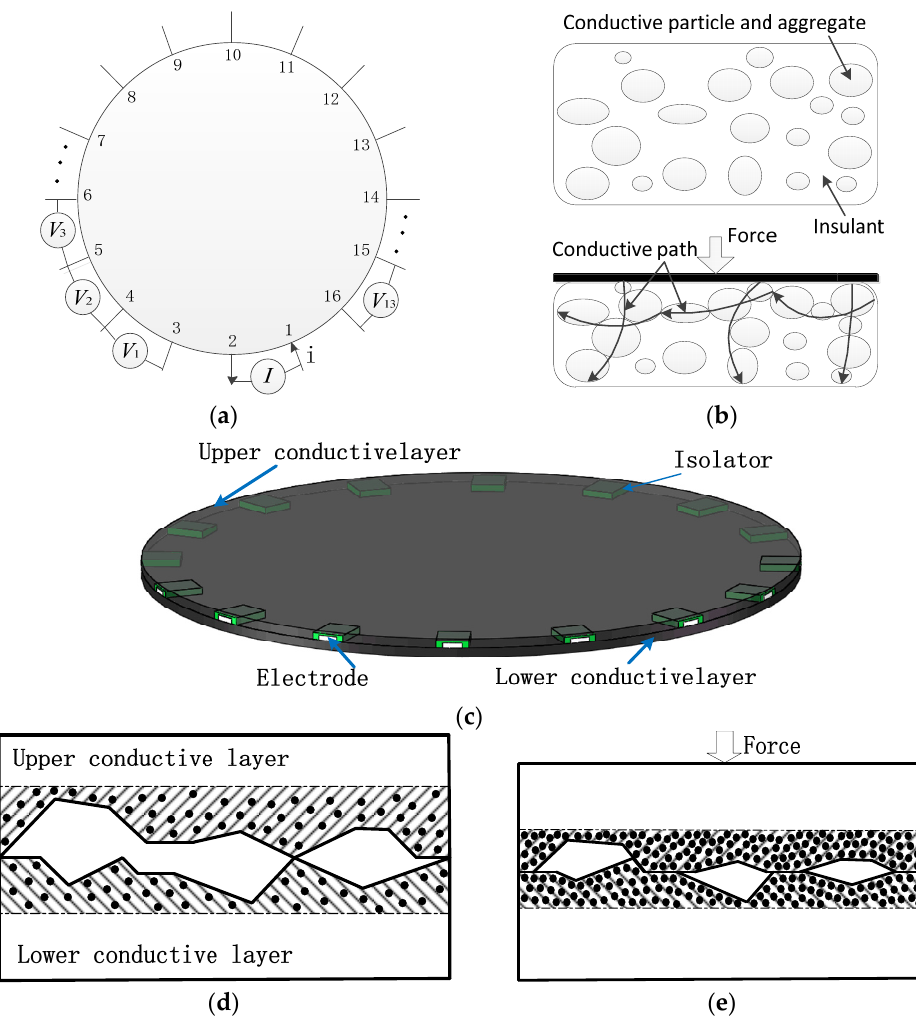
Figure 1. The structure and principle of double-layer piezoresistive sheets tactile sensor: ( a ) The schematic of sensor; ( b ) Microcosmic mechanism after the piezoresistive film is pressed; ( c ) Three- dimensional model of the sensor with two-layer structure; ( d ) Schematic diagram of high impedance state; ( e ) Schematic diagram of low impedance state.